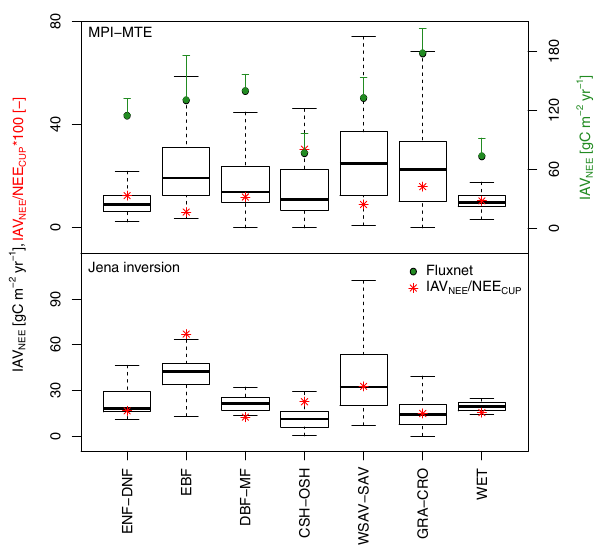
Figure 6. Boxplot of NEE inter-annual variability averaged in PFT classes for MPI-MTE NEE and the Jena Inversion; green dots rep- resent observations at FLUXNET sites (different y scale on the right) plotted with their standard error. PFT classes are grouped as follows: evergreen needleleaf forests and deciduous needleleaf forests (ENF-DNF), evergreen broadleaf forests (EBF), deciduous broadleaf forests and mixed forests (DBF-MF), closed and open shrublands (CSH-OSH), woody savannahs and savannahs (WSAV- SAV), grasslands and croplands (GRA-CRO), and wetlands